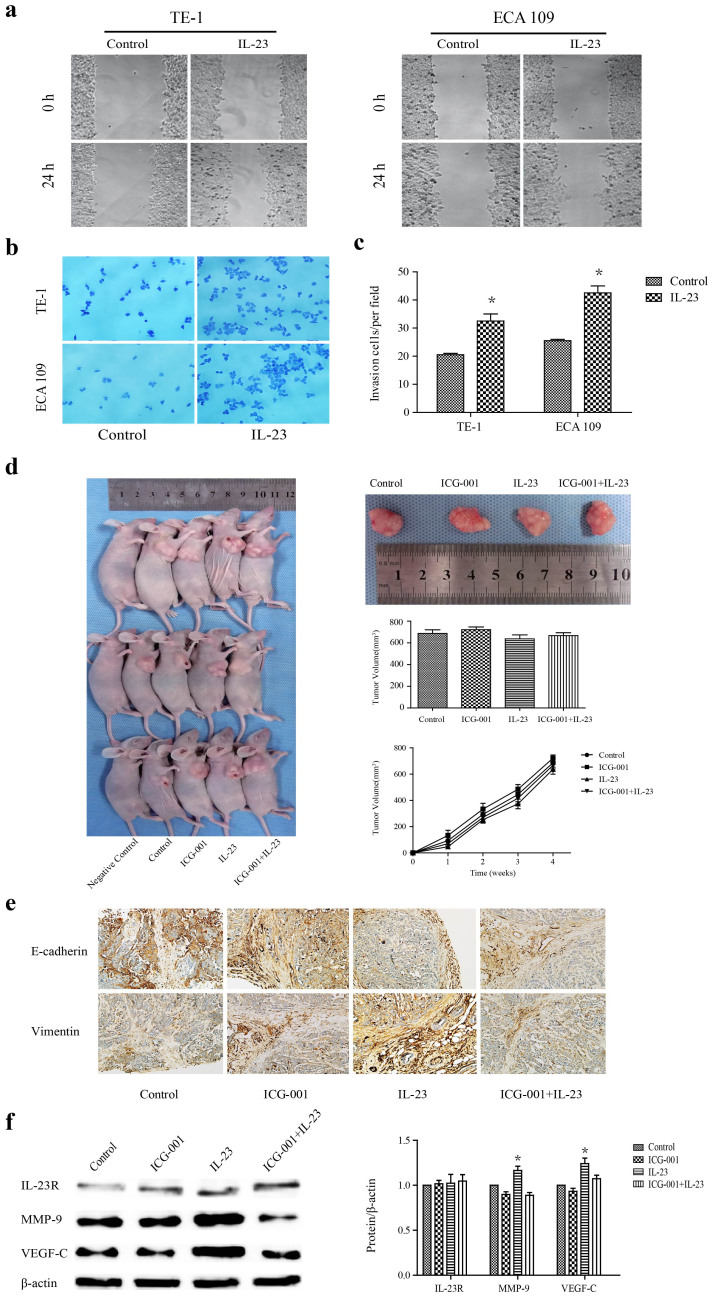
IL-23 enhanced OC cells motility.Confluent monolayers of TE-1 and ECA 109 cells were wounded and the migratory capacity of the cells was measured at 24 h or 48 h by counting the number of cells per field in at least 8 fields from three different experiments. (a) Representative wounds in monolayers of OC cells treated with IL-23 (50 ng/ml) are shown in comparison to untreated controls. (b) The migration-inducing effect of the application of IL-23 in TE-1 and ECA 109 cells. (c) Quantification of the invasion-inducing effect of IL-23-treatment (50 ng/ml). (d) The results showing the changes in volume and terminal states of tumours. (e) Immunohistochemical results show the transformation due to IL-23 in xenograft tumours, using E-cadherin and vimentin as the indicators. (f) The collected tissue homogenates were used to detect the levels of IL-23R, MMP-9 and VEGF-C by immunoblotting. Data represent mean values from at least three independent experiments. Asterisks indicate the level of significance in the charts. *p < 0.05.